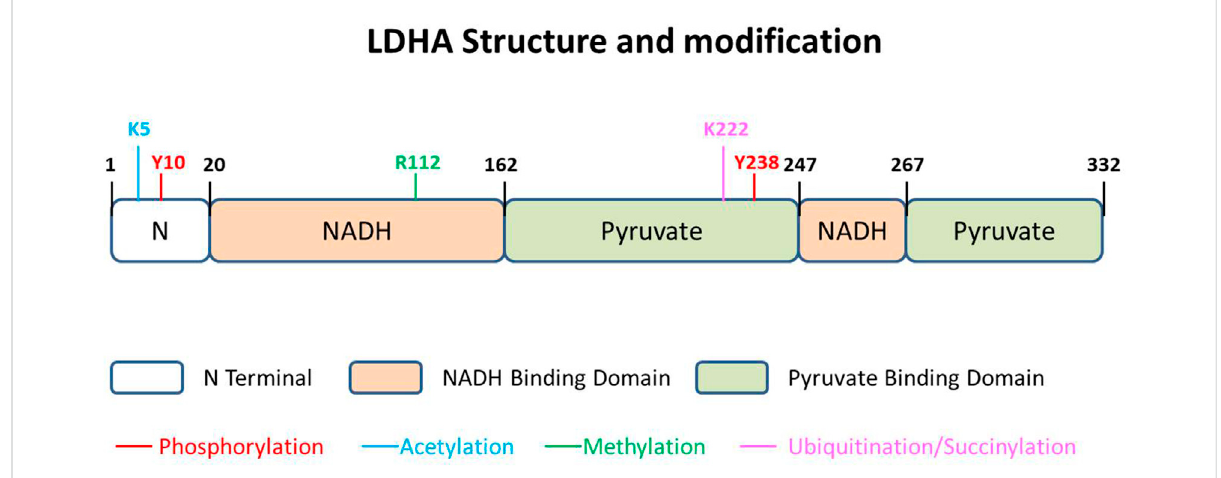
FIGURE 2 LDHA structure and modi fi cation. The 332-amino acid protein could be described as having three parts, N terminal domain, NADH-binding domain, and pyruvate-binding domain. There are fi ve kinds of modi fi cations that have been reported in different sites of LDHA, namely, phosphorylation, acetylation, methylation, ubiquitination, and